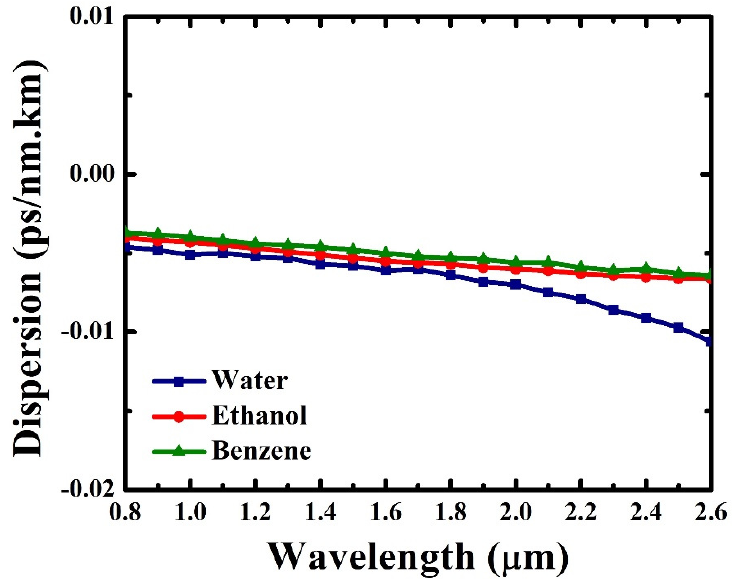
Figure 8. Chromatic dispersion of the proposed design with respect to wavelength for water, ethanol and benzene. Table 1. Comparison among the variation in global parameters on optimum parameters at λ = 1.3 µ